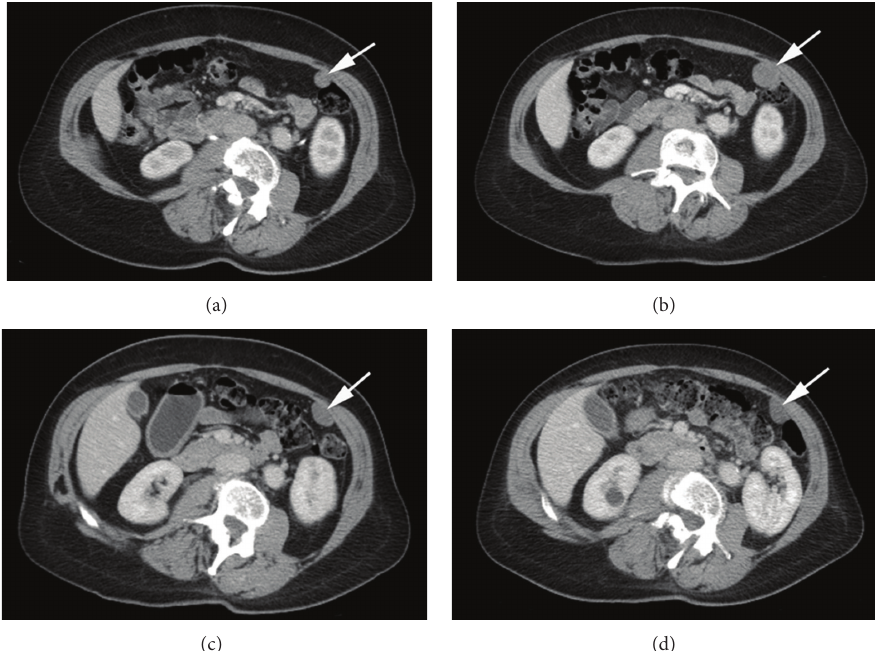
Figure 1: Axial contrast enhanced CT images show a peritoneal deposit within the left side of the abdomen (arrows). Prior to commencing sirolimus, the deposit progressed by RECIST 1.1 over a period of 6 months ((a) and (b)). CT staging at 4 months (c) and 13 months (d) on treatment with sirolimus showed that the deposit had reduced in size but was within the limits of stable disease by RECIST v1.1. A further pelvic deposit (not shown) also reduced in size but overall disease remained stable by RECIST v1.1. However, assessment by Choi criteria which incorporates attenuation changes classified disease status as partial response at 4 months and further partial response at 13